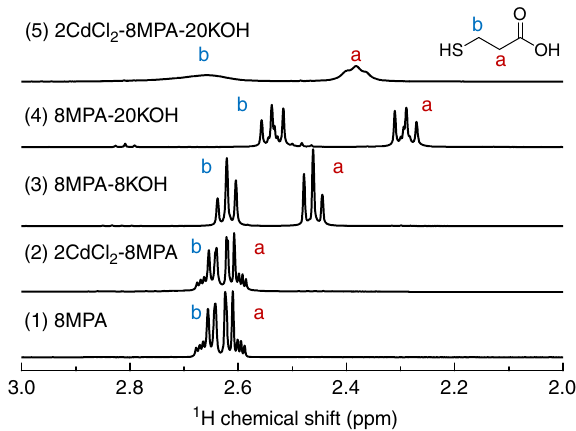
Fig. 4 1 H NMR spectra of fi ve MPA-containing solutions in D 2 O. The MPA concentration is 40.0 mM for the fi ve solutions, which consist of 8MPA (1), 2CdCl 2 -8MPA (2), 8MPA-8KOH (3), 8MPA-20KOH (4), and 2CdCl 2 -8MPA-20KOH (5). The feed molar ratio indicated follows that of the mixture studied in Fig. 1, while the CdCl 2 concentration in Solutions 2 and 5 is 10.0 mM. For the MPA molecule, the two protons of the two methylene groups are labeled as a and b. Evidently, the formation of the Cd – MPA complex involves the deprotonation of the thiol group. Compared to trace 4, the chemical shift and broadening of the two resonance signals